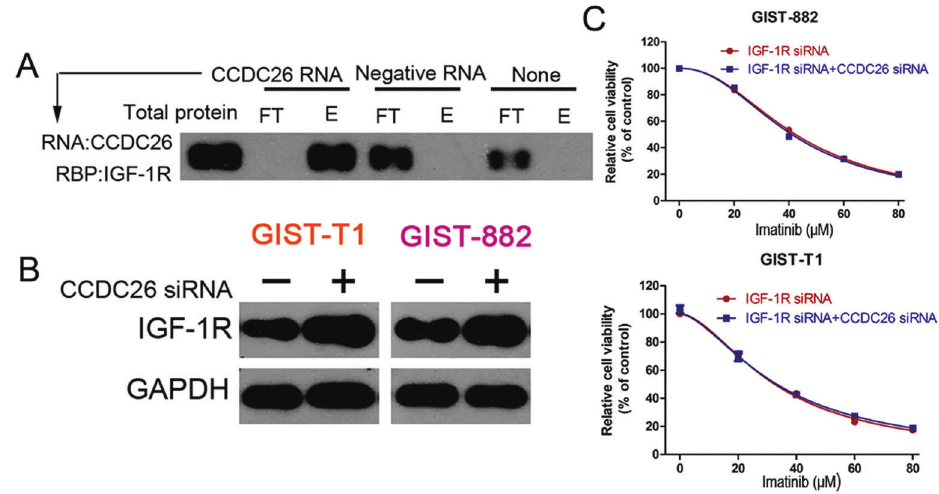
Figure 4. CCDC26 pull down of IGF-1R and its regulation and expression. A , Expression levels of IGF-1R were assayed in CCDC26 RNA group (target), control RNA group (unrelated), and blank group (none) following RNA pull down (FT: fl ow-through T: eluate). B , Expression of IGF-1R in GIST-T1 and GIST-882 cells with the transfection of CCDC26 siRNA or control RNA. C , Cell viability of GIST-T1 and GIST-882 cells transfected with IGF-1R siRNA with control siRNA or CCDC26 siRNA, and IGF-1R siRNA treated with different concentrations of imatinib for 48